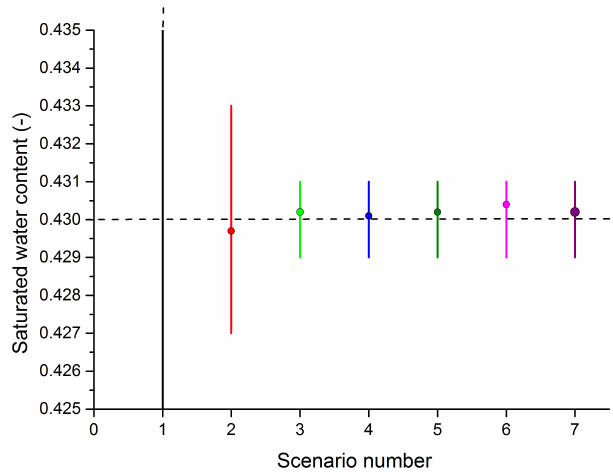
Figure 9. Posterior mean values and 95% confidence intervals of the saturated hydraulic conductivity for the different scenarios. Figure 10. Posterior mean values and 95% confidence intervals of the saturated water content for the different